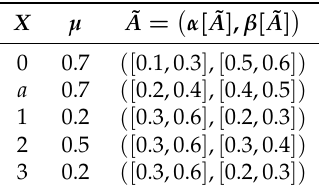
Table 6. Tabular representation of A = (cid:104) µ , ˜ A (cid:105)